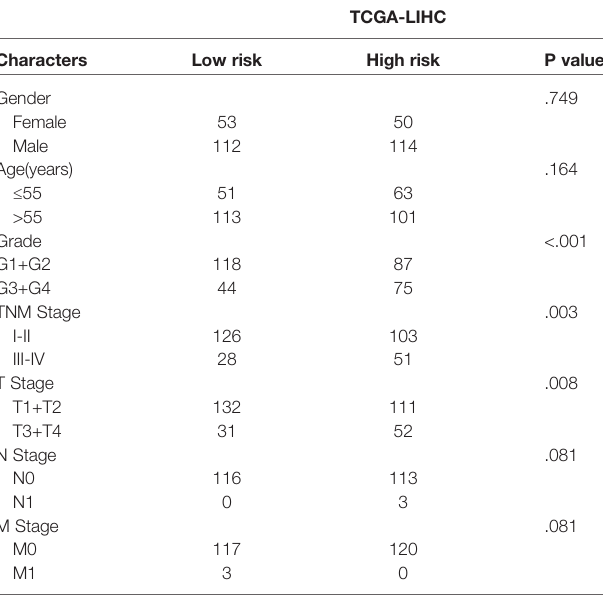
TABLE 1 | Clinical characteristics between the high- and low-risk groups.